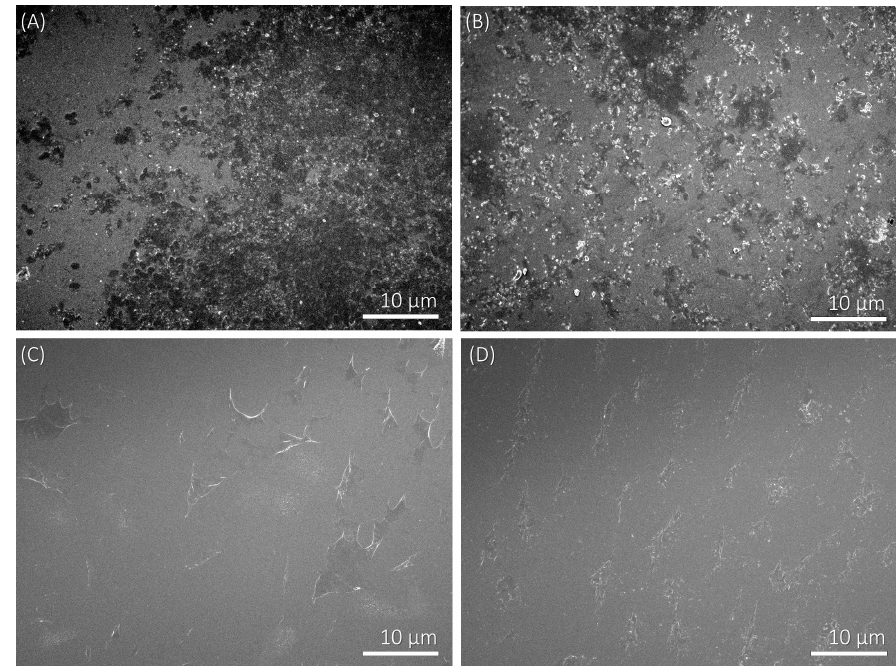
Figure 3. SEM micrographs of P. aeruginosa bacteria adhered on the polyelectrolyte multilayer surface at 2000× magnification. ( A ) Adhered bacteria on a SiO 2 plate which is covered with five polyelectrolyte layers and the terminating layer has a positive electric charge (PAH); ( B ) Adhered bacteria on a SiO 2 plate which is covered with six layers and the last adsorbed layer has a negative electric charge (PSS); ( C ) The negative control of SiO 2 plates with five adsorbed polyelectrolyte layers; ( D ) The negative control of SiO 2 plates with six adsorbed polyelectrolyte layers.